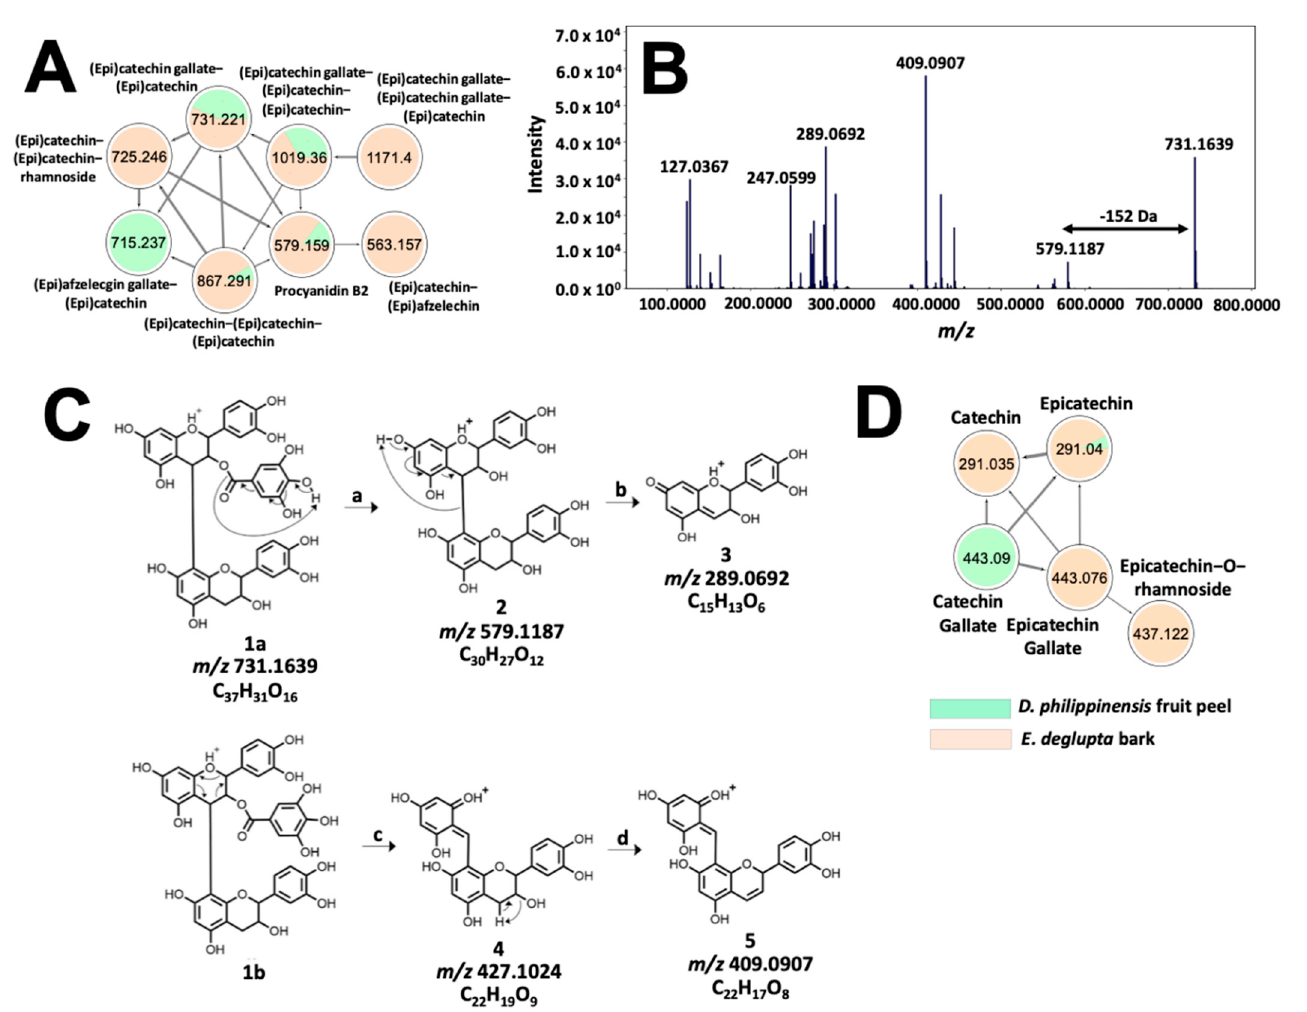
Figure 7. Molecular networking and fragmentation analysis of proanthocyanidins common to D. philippinensis and E. deglupta . Clustering of complex tannins is shown in ( A ); tandem MS spectrum of m/z 731.1667 is presented in ( B ) and served as the basis for fragmentation analysis that characterized the precursor ion as epicatechin-O-gallate-epicatechin ( C ). On the other hand, a smaller network of flavan-3-ol and their galloylated and glucosylated analogs is described in ( D ).